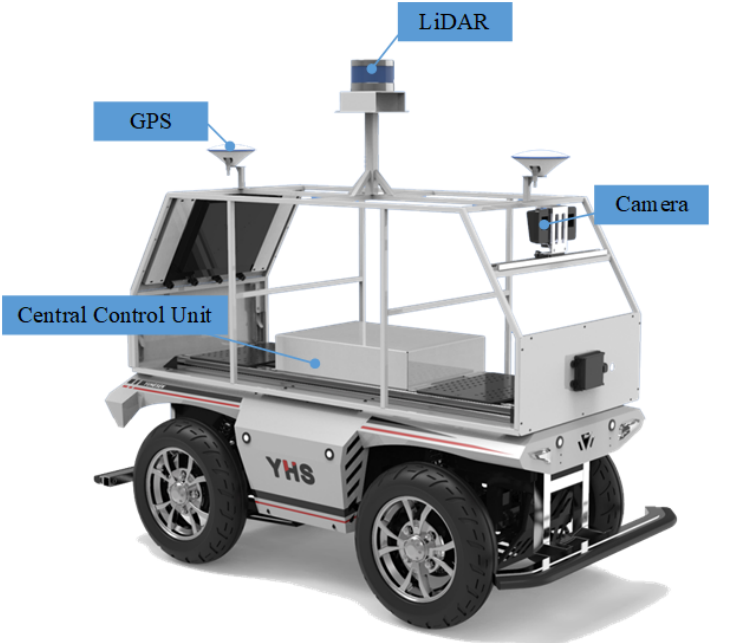
Figure 2. The autonomous car with multiple sensors including LiDAR, camera, GPS, and so